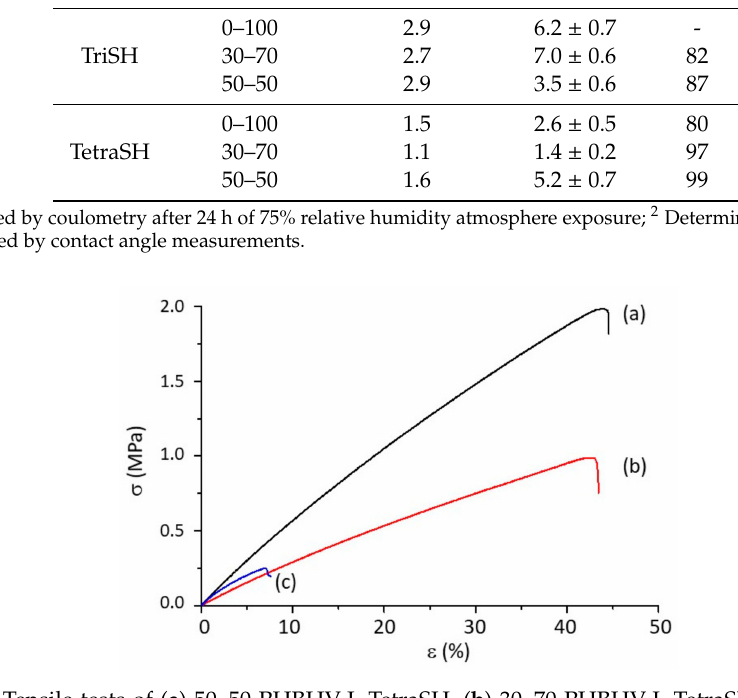
Figure 5. Tensile tests of ( a ) 50–50 PHBHV-L TetraSH, ( b ) 30–70 PHBHV-L TetraSH and ( c ) 50–50 PHBHV-L TriSH co-networks (typical